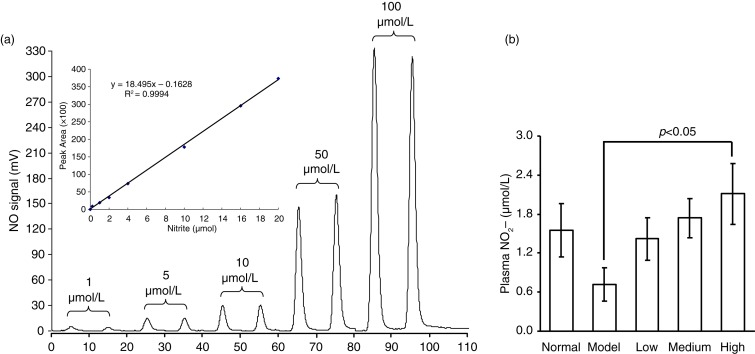
The effect of dietary spinach nitrate on the plasma NO2- levels. (a) The NO signal intensity of different concentrations of NO2- and the corresponding standard curve. (b) The plasma NO2- concentration in mice treated with spinach at different dosages of nitrate. Results are expressed as means±SD of eight mice in each group.